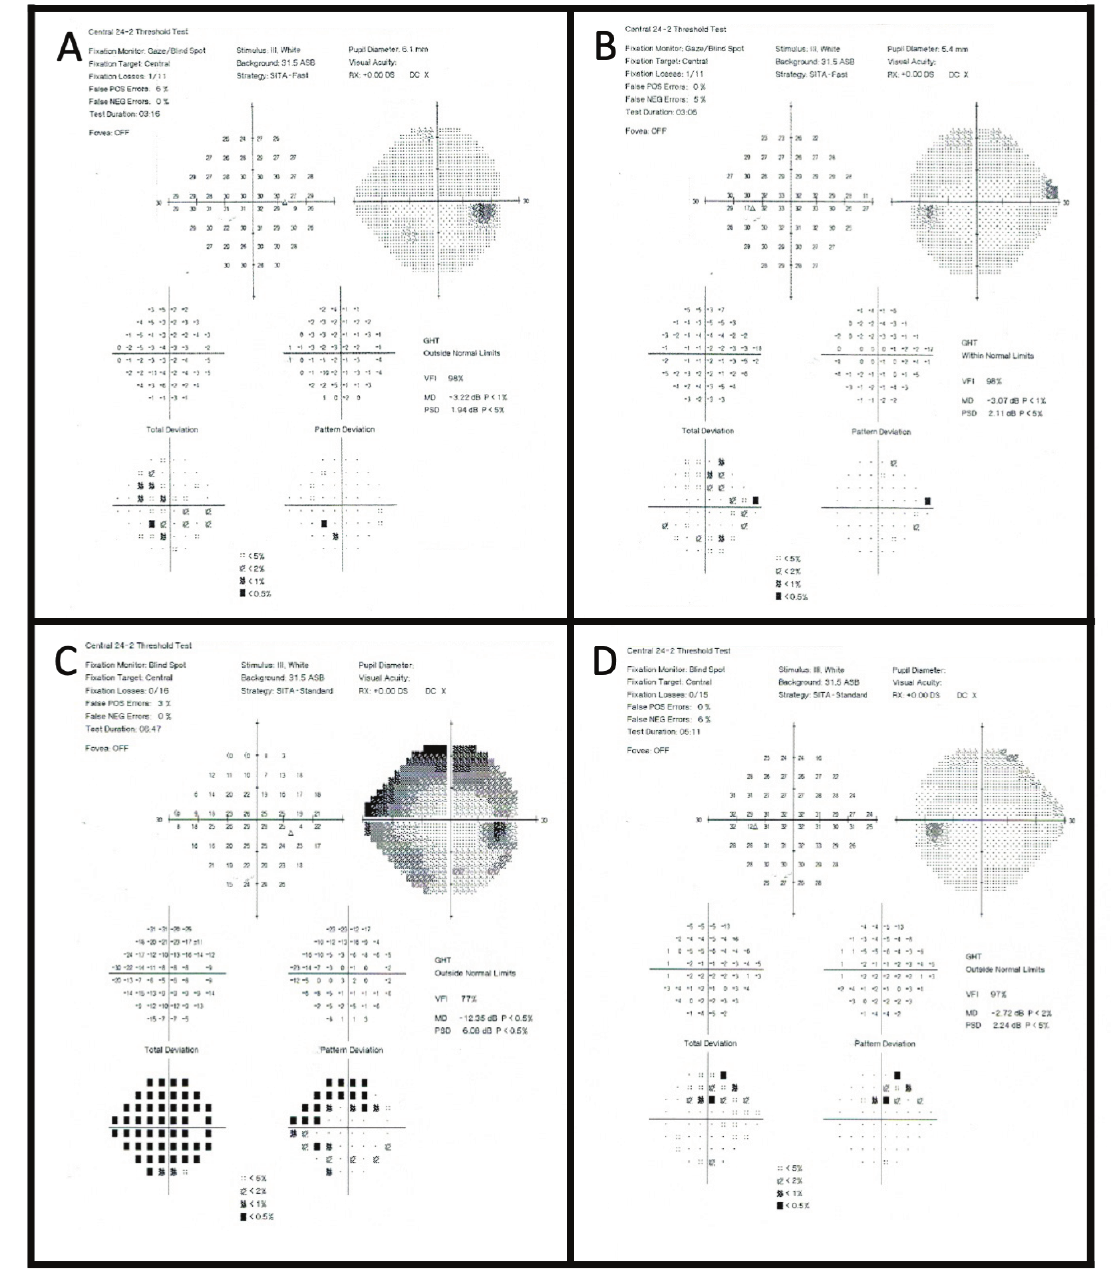
Figure 2. (A & B) 24-2 Humphrey visual field of right and left eyes at initial presentation. (C & D) 24-2 Humphrey visual field of right and left eyes five months after initial presentation to our clinic showing superior arcuate and inferior nasal defects in the right